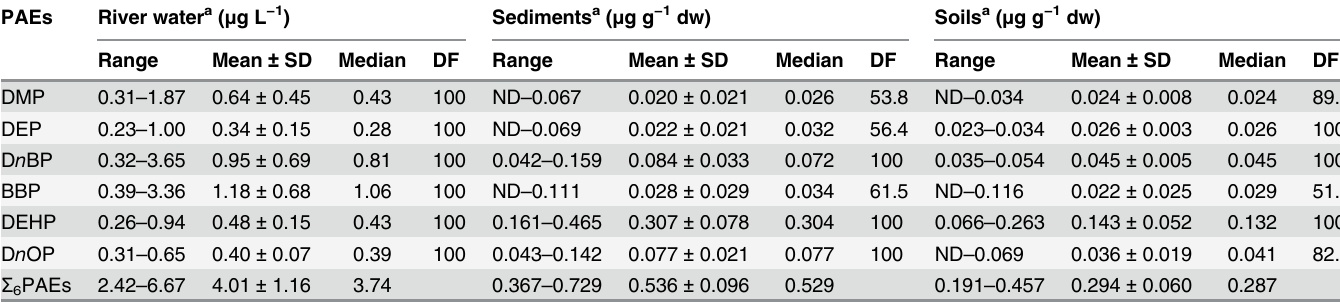
Table 1. Summary of the individual concentrations of PAEs in the WYR water, sediments, and agricultural soils ( n = 39). PAEs River water a ( μ g L − 1